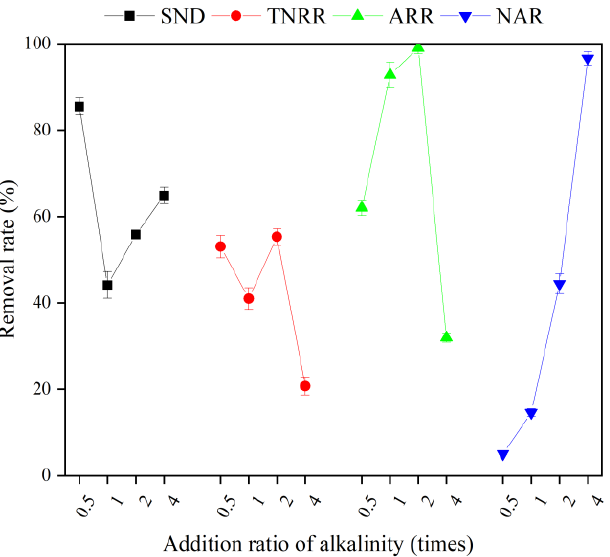
Figure 6. The performance of Short-SND with different alkalinity addition ratios in MBBR. Vertical bars represent ± SD of the means ( n = 3).